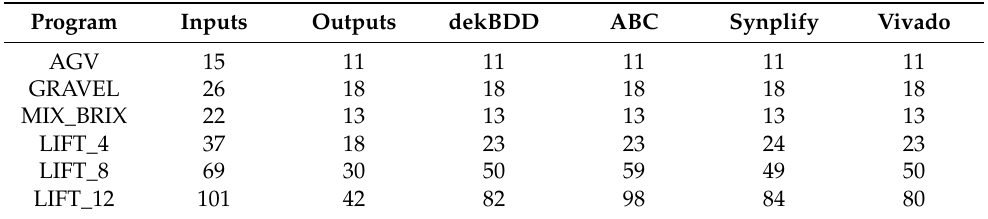
Table 1. LUT blocks utilization for the logic part of the controller and respective mapping